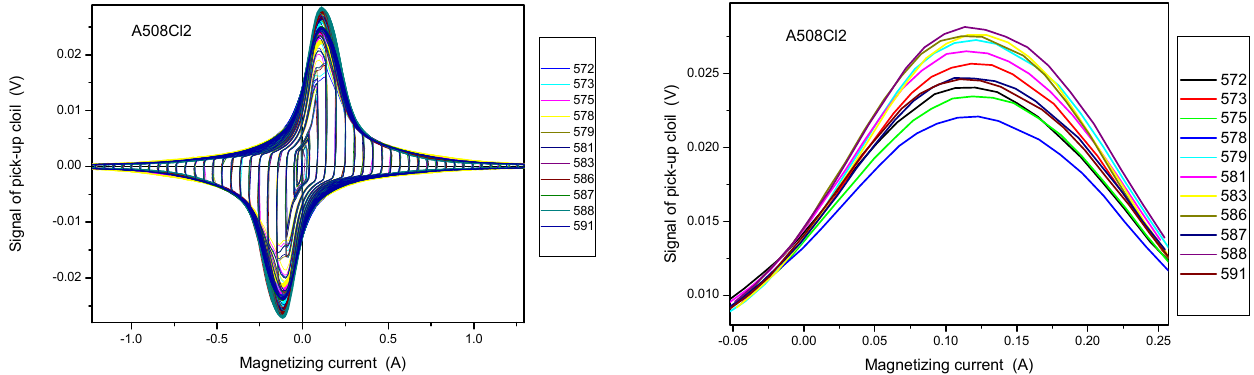
Figure 10. Measured permeability loops of A508 Cl.2 samples before irradiation. The right panel shows the magnified part of the left graph.